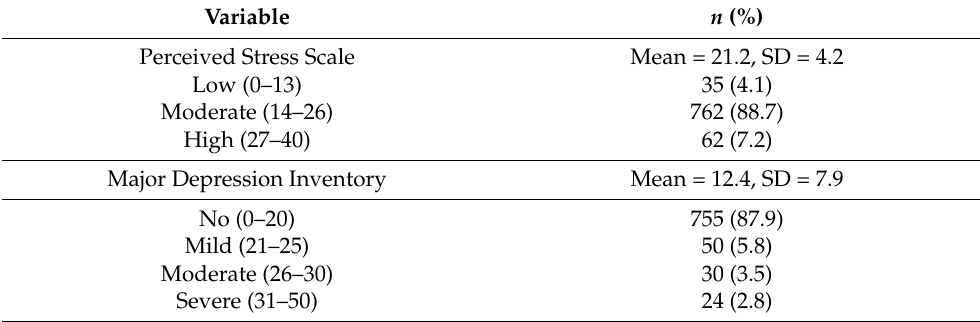
Table 2. Perceived Stress Scale and Major Depression Inventory score of the participants (N = 859).